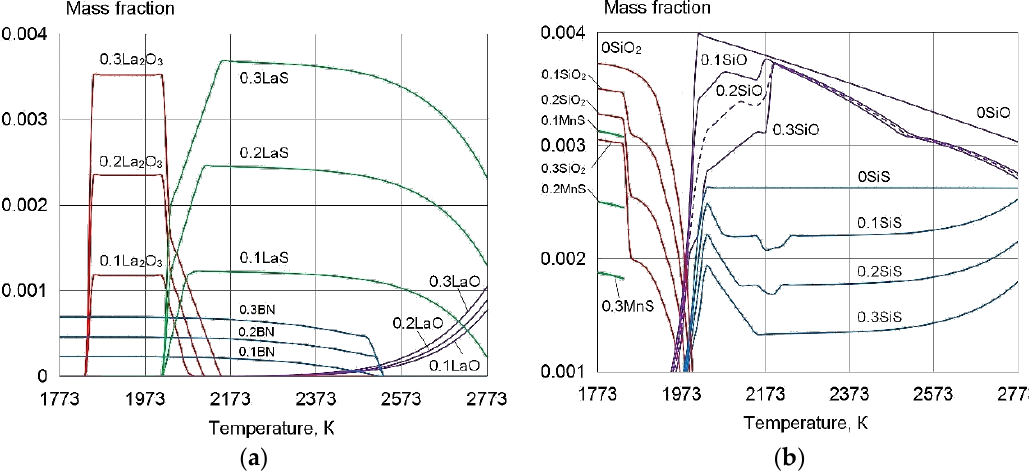
Figure 4. The equilibrium phase composition of the weld pool of G3Si1 type, wt%: 0.09C, 0.8Si, and 1.3Mn with the addition of La and B: ( a ) La 2 O 3 , LaO, LaS, BN; ( b ) SiO 2 , SiO, MnS. Corresponding contents of La and B are indicated before compounds, wt%: (0) without REE; (0.1) (0.1La+0.01B); (0.2) (0.2La+0.02B); (0.3) (0.3La+0.03B).